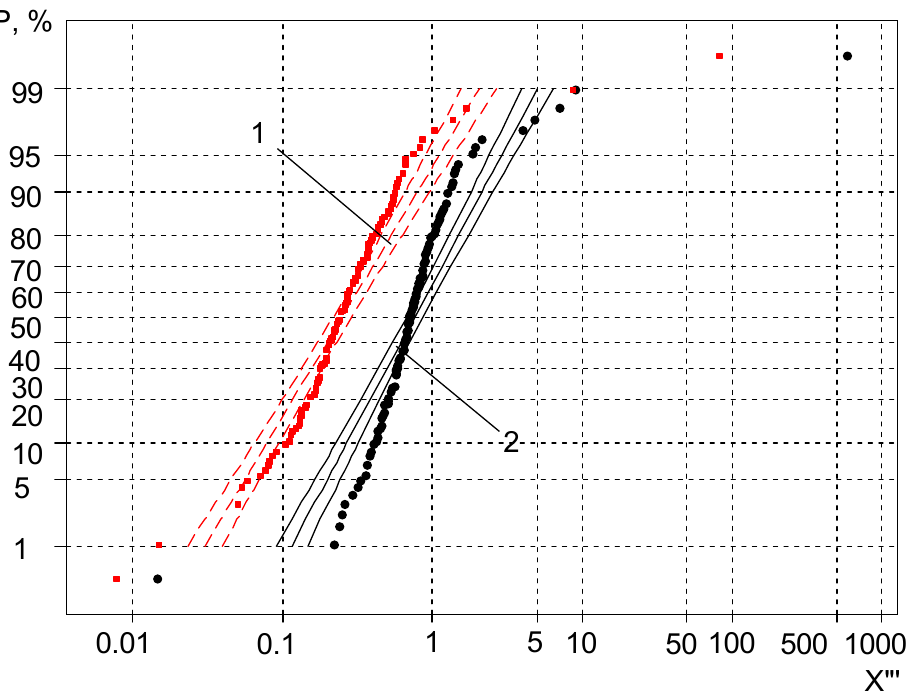
Figure 6. Statistical distribution curves for the mechanical properties of steel 15Cr2MoVA with identified sensitivity thresholds N 0 and N k (1— ψ , 2— ψ u ).